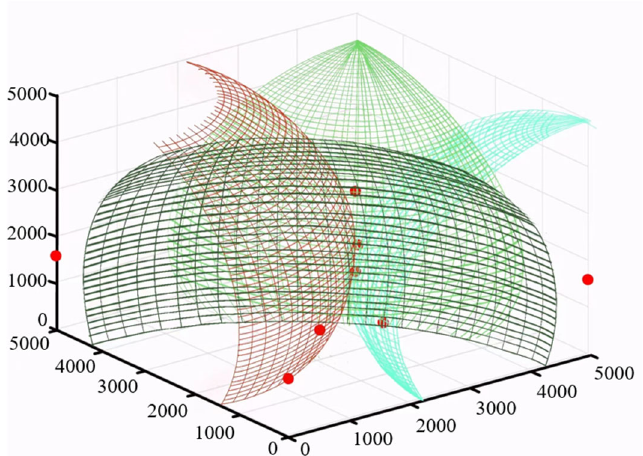
Figure 11. Schematic diagram of abnormal data error.